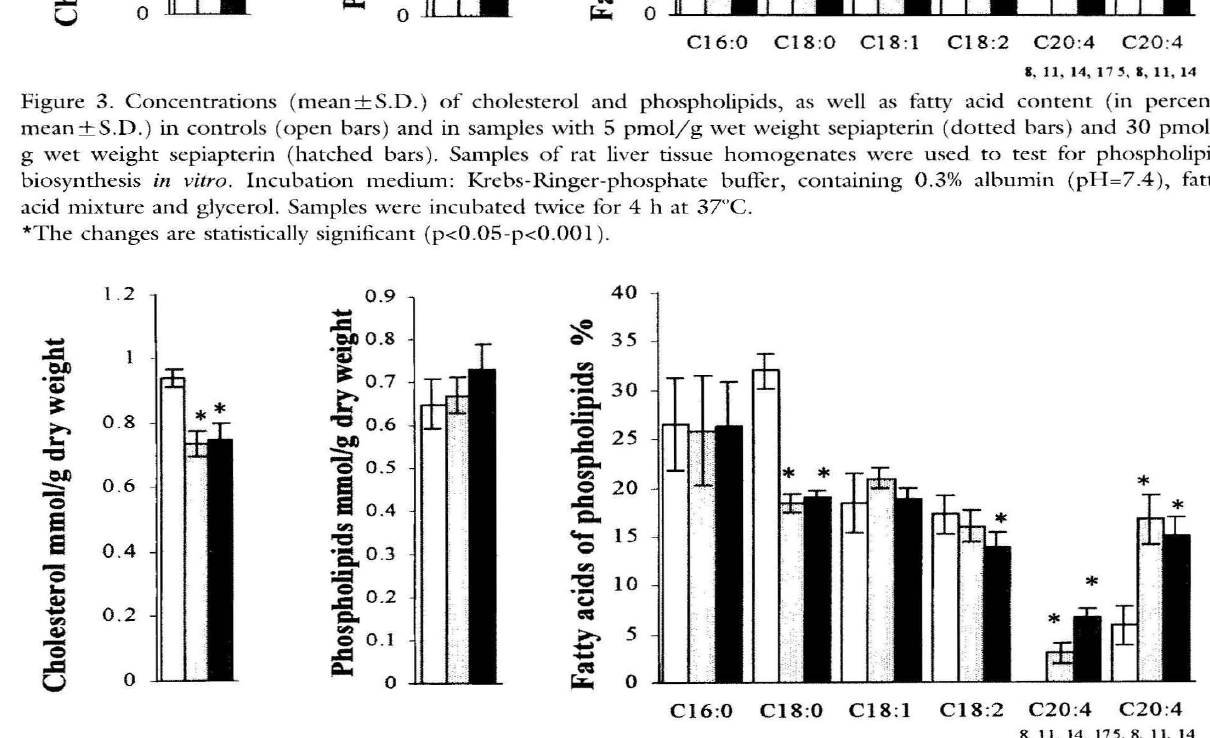
Figure 4. Concentrations (mean ± S.D.) of cholesterol and phospholipids, as well as tatty acid content (in percent: mean±S.D.) in controls (open bars) and in samples with 5 pmoljg wet weight 7,8-dihydrobiopterin (dotted bars)